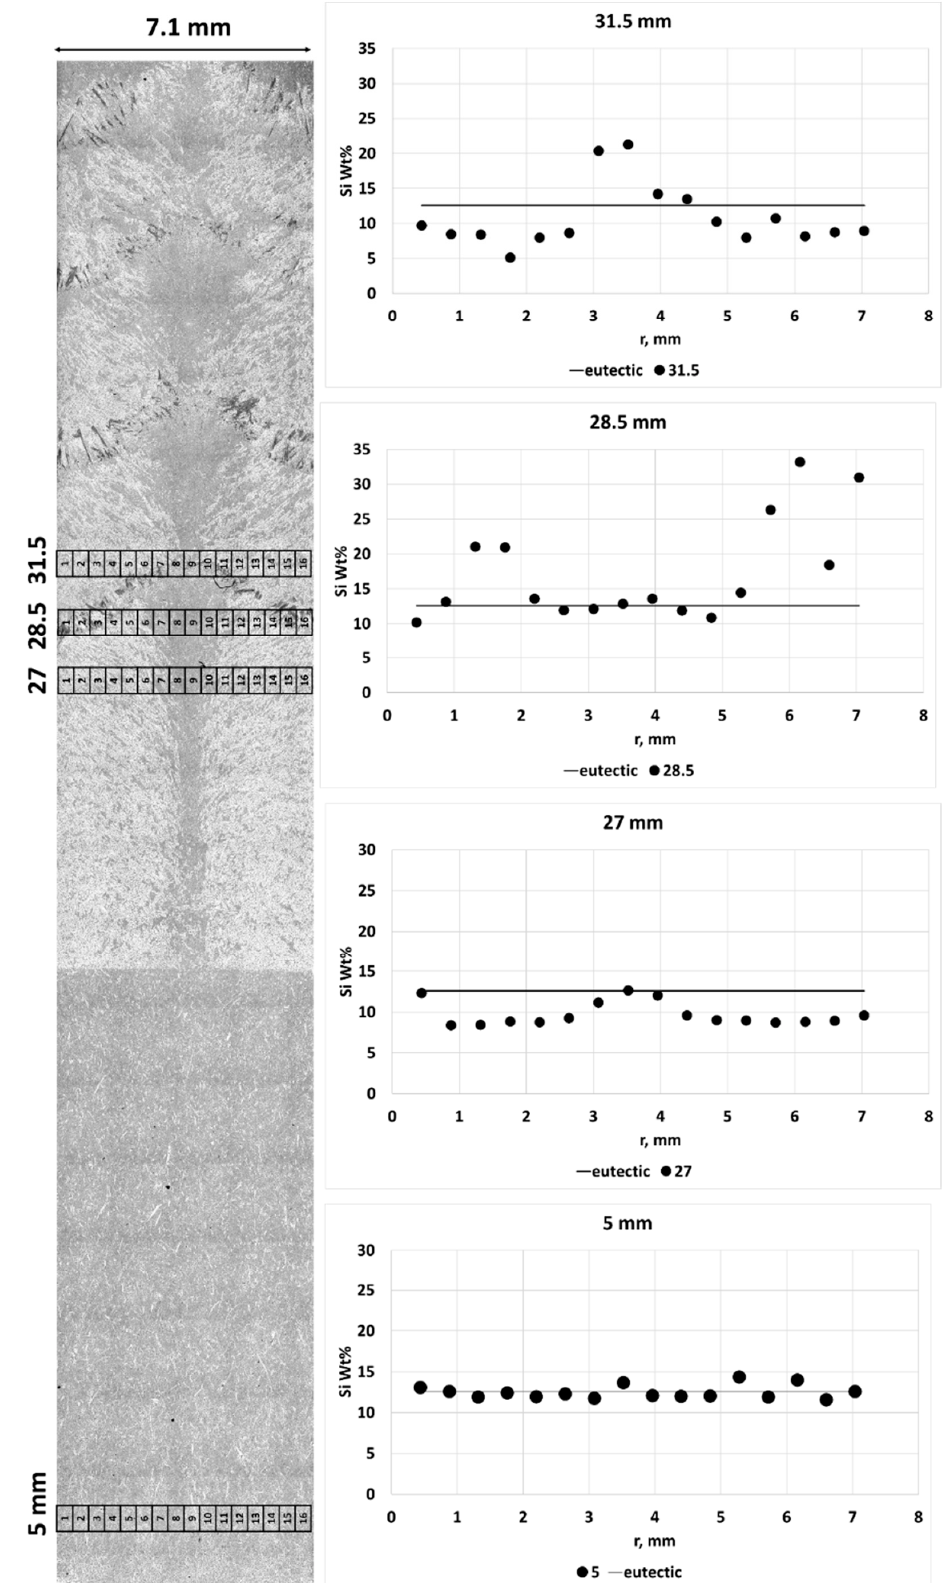
Figure 8. Si-concentration distribution along the diameter in C sample at steps 1 and 2.